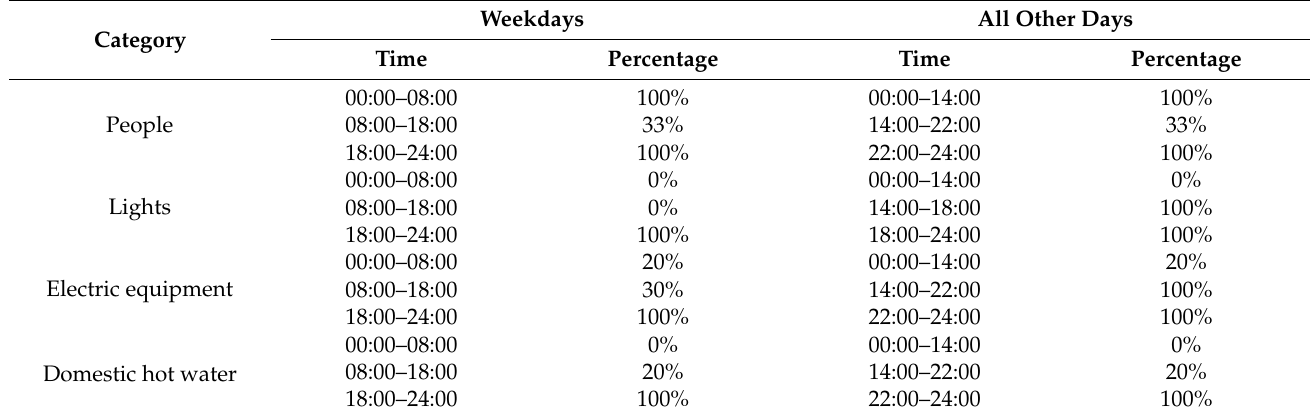
Table 5. Scheduling of internal heat